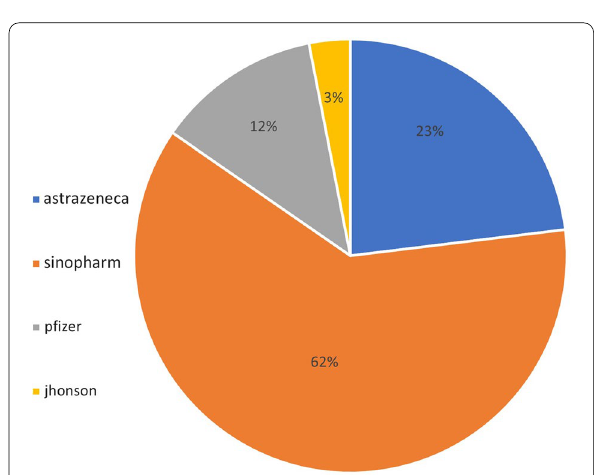
Fig. 2 Percentage of different types of vaccines received by MS